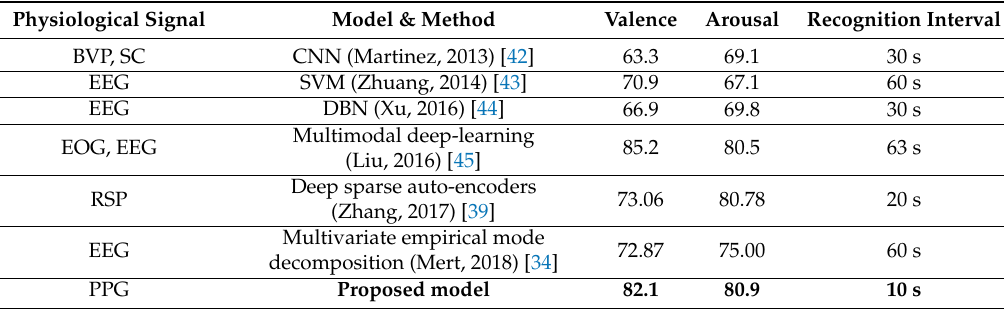
Table 5. Comparisons with other studies using DEAP for classification accuracy and recognition